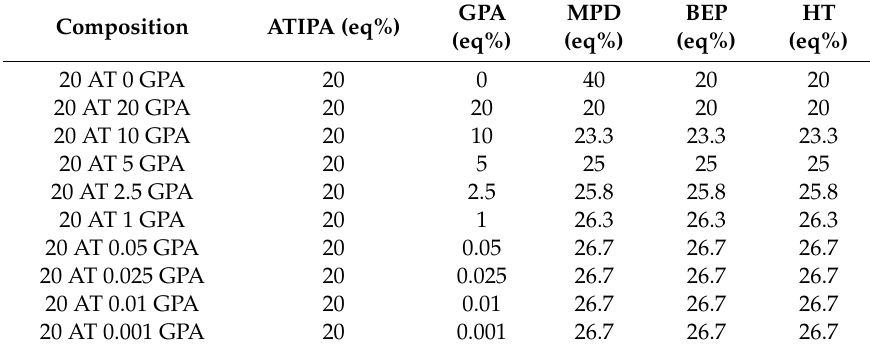
Table 1. Hydroxyl components of shape memory polymer compositions synthesized for use in all studies.